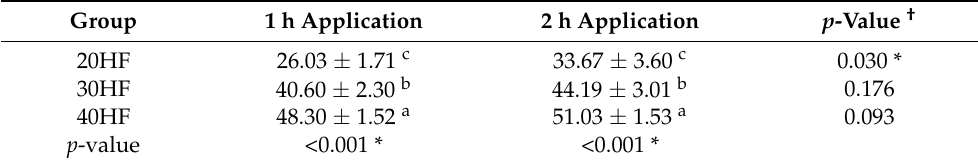
Table 5. Means and standard deviation of average surface roughness (Ra) for each group